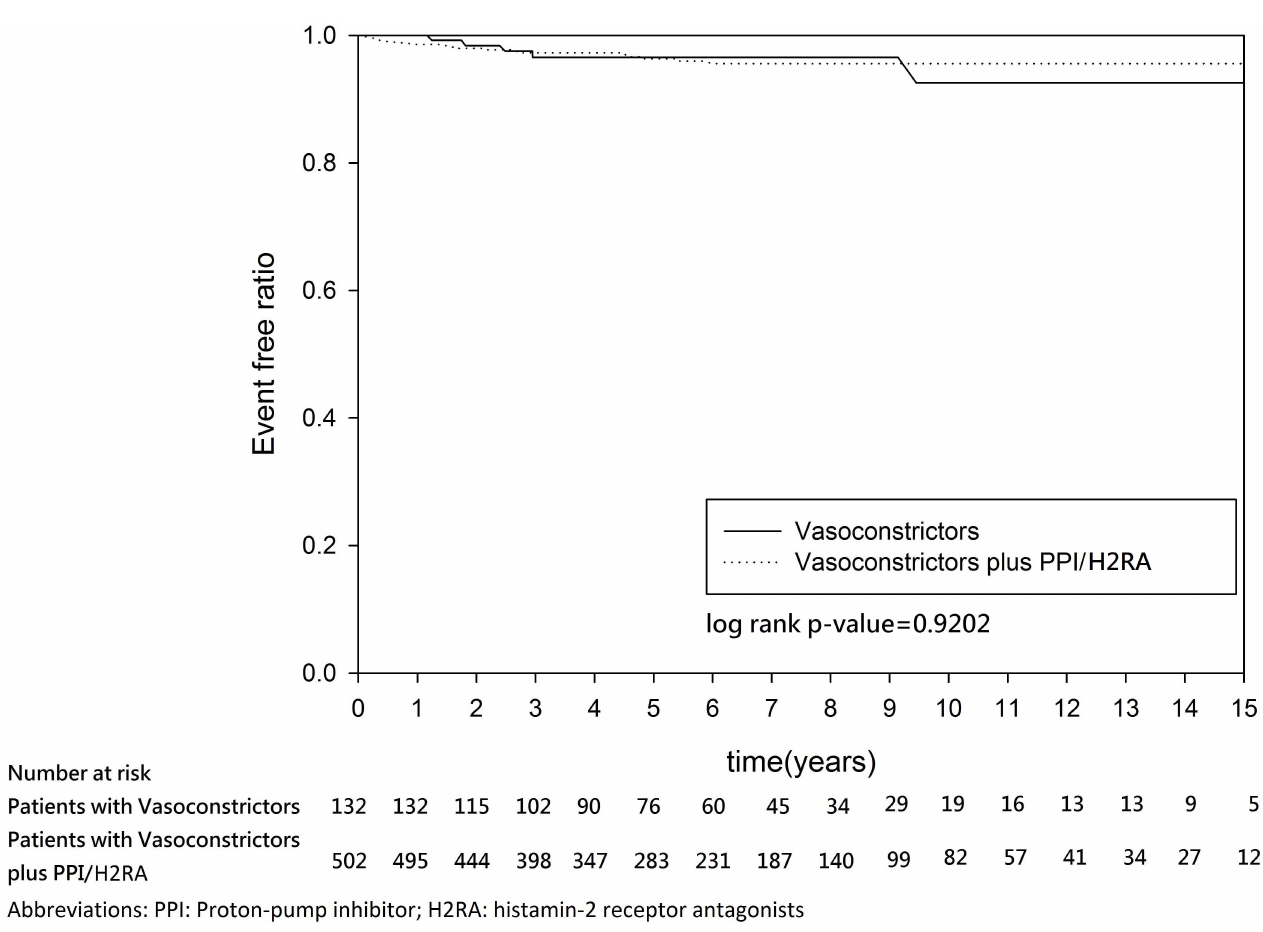
Fig 3. Kaplan–Meier estimatesfor the absence of re-bleeding in patients with cirrhosis and esophageal varicealbleeding (15 yearsfollow- up).